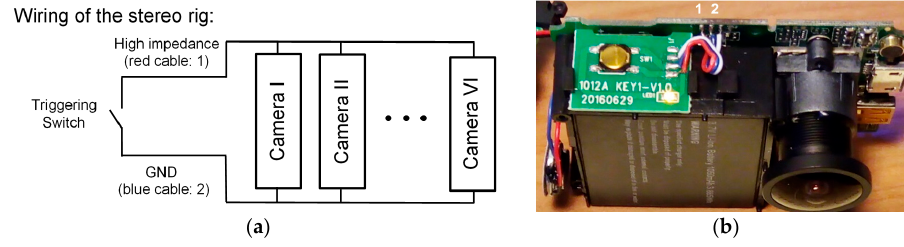
Figure 3. Wiring detail for the synchronization of the six cameras. ( a ) Circuital scheme; ( b ) A disassembled camera showing the location of the electrical connections labeled “1” and “2”.